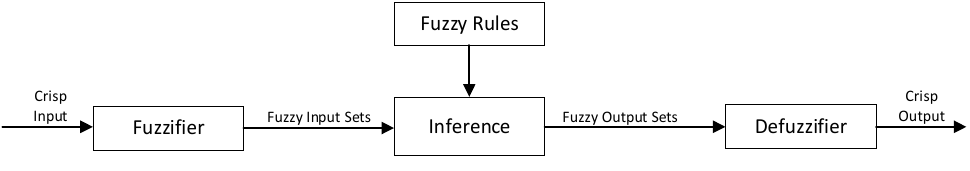
Figure 1. The s chematic diagram of the fuzzy logic system. Figure 1. The schematic diagram of the fuzzy logic